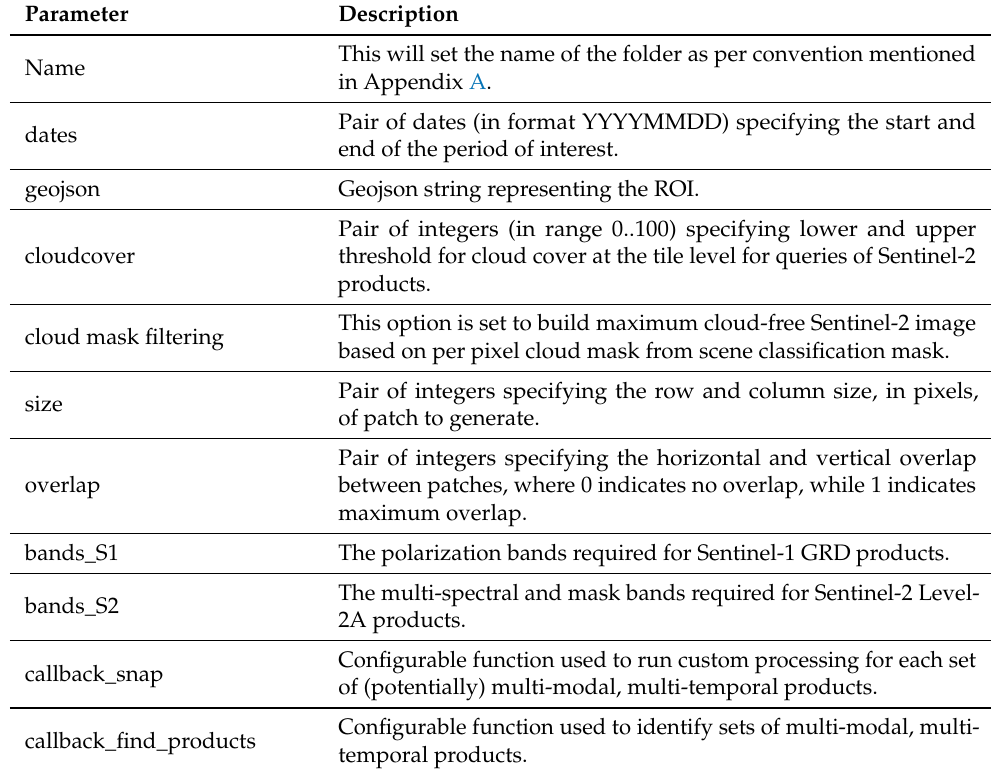
Table A1. Parameters used in configuration of the ARD